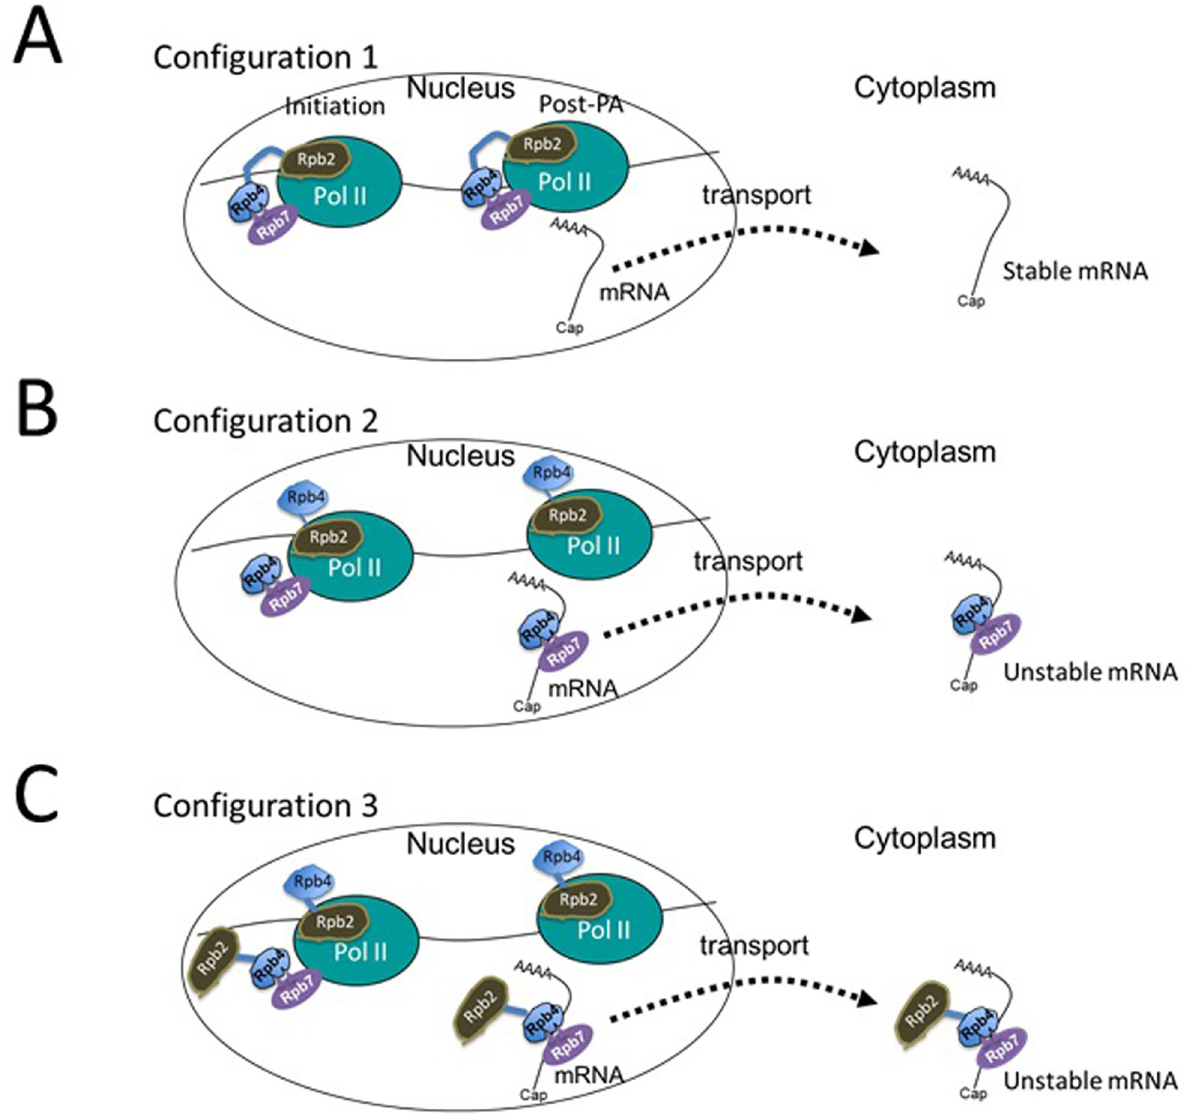
Fig 6. A proposed model: Different configurations of Pol II with different impact on post-transcriptional stage. The left Pol II complex represents initiating and elongating complex (for simplicity the nascent transcript is not shown), whereas the one at the right—the post- polyadenylation complex. The transcript represents mature one containing the 5’ cap and the 3’ poly(A) tail (represented as AAAA). Following transport, the same transcript is found in the cytoplasm (at the right). See also models in [18,20].Rpb2-Rpb4 fusion is represented by its two moieties: Rpb2 (brawn), Rpb4 (blue), and the flexible linker between them is represented as a blue line (not drawn to scale). We propose the co-existence of three configurations of Pol II complex. “Configuration 1” that assembles the fusion protein as expected; Rpb2 and Rpb4 are placed in their natural positions and support normal transcription. The resulting transcript is exported without Rpb4 (and maybe without Rpb7) because Rpb4 cannot dissociate from Pol II. Since this transcript cannot bind Rpb4 after its dissociation from Pol II, the exported mRNA is relatively stable (Fig 2 and [15,20,21,40] and relatively poorly translated (Fig 4 and [18,19]). This configuration seems to be responsible for the uncoupling that we found between mRNA synthesis and decay. Note, however, that no proof was provided for the assumption that the fusion protein cannot dissociate from